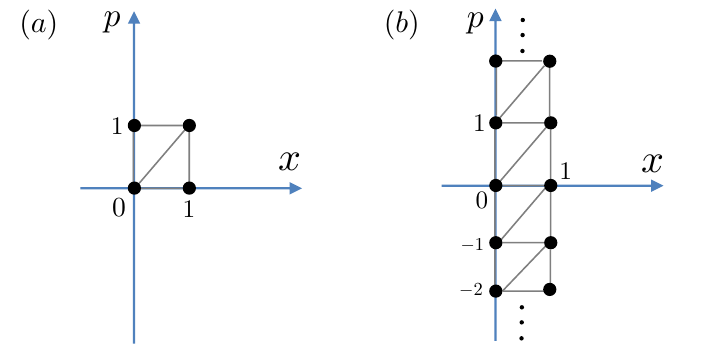
Figure 5 . The toric diagrams of the mirror curves. The left corresponds to the 1-chain geometry, and the right panel corresponds to the periodic 1-chain